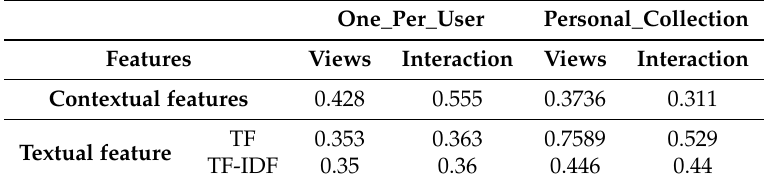
Table 7. Performance of contextual and textual features in the prediction of